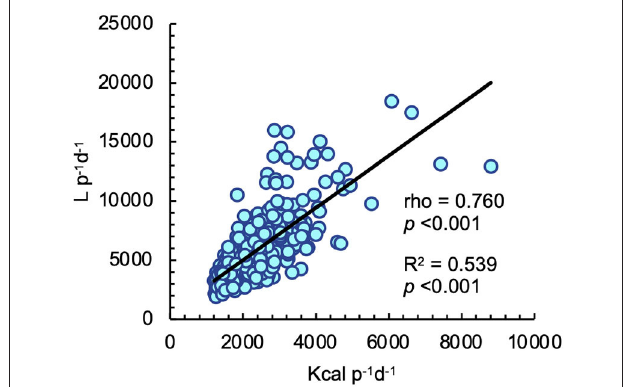
FIGURE 3 | Simple linear regression model between caloric intake and dietary total water footprint (WF). Statistical significance was considered at p ≤ 0.05. rho was obtained from spearman